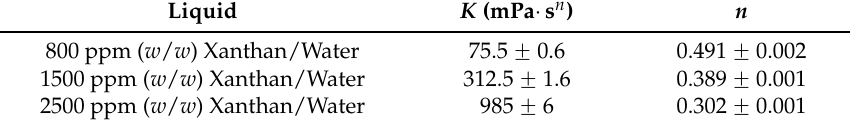
Table 2. Fitting parameters of the power-law fit of the xanthan solutions.